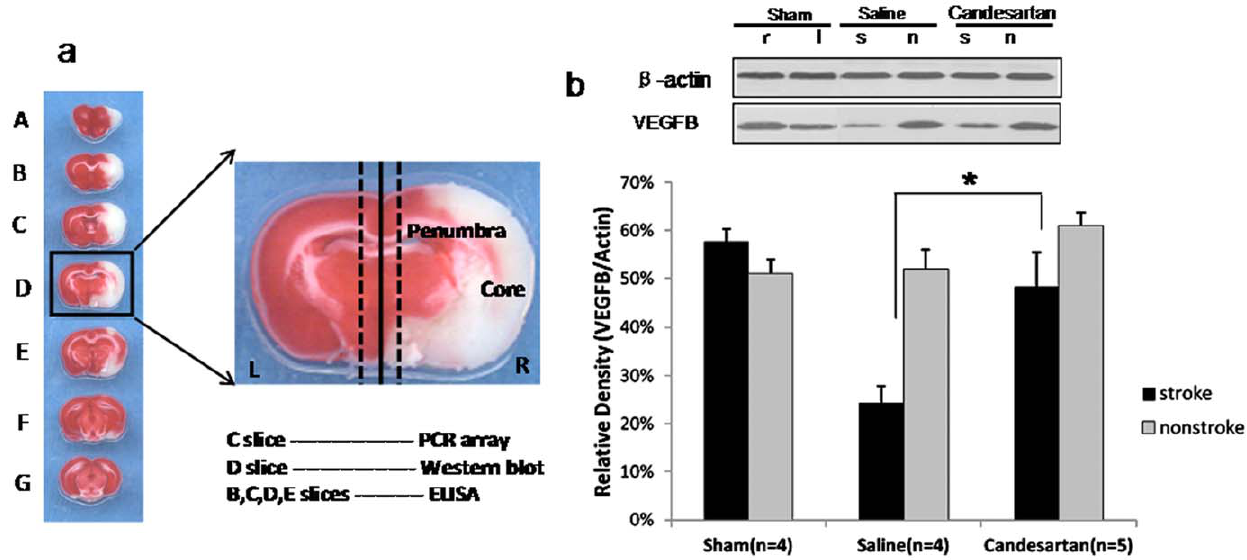
Figure 4. VEGFB expression in the brain. Western blot was performed on brain tissue from sham animals, candesartan and saline treated animals at 24 hours after stroke onset. Brain tissue samples were taken as shown in Figure 4a.There was a significant interaction between treatment groups. For the saline-treated animals, the ischemic hemisphere had lower VEGFB expression compared with the nonischemic hemisphere (P=0.012).However, there was no significant difference between the two hemispheres for the sham animals (P=0.88) or candesartan-treated animals (P=0.29). Candesartan treatment significantly preserved VEGFB protein expression in the ischemic hemisphere (Figure 4b,*P , 0.05) as compared with saline-treated